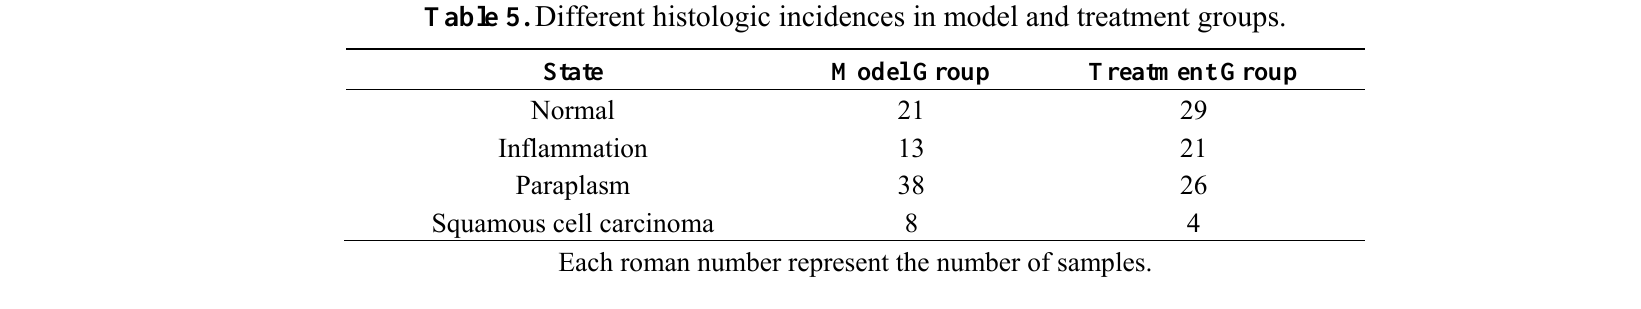
Table 6. VEGF positive expression rates in model and treatment